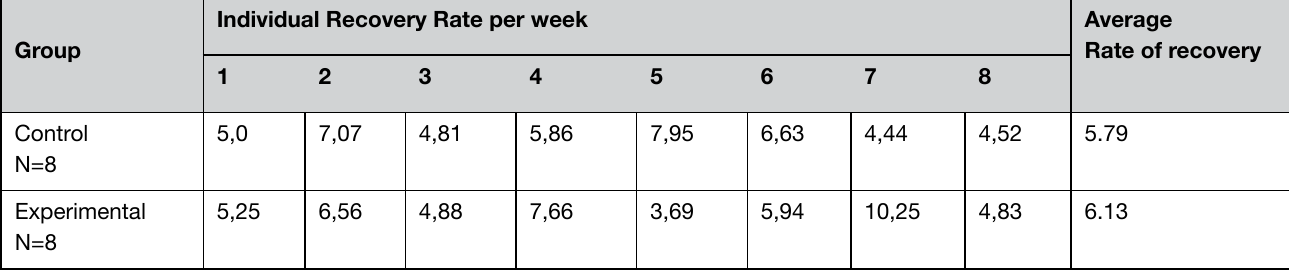
Table 3: Mann-whitney tests for FDi recovery rates (Ranks) n Mean rank Sum of